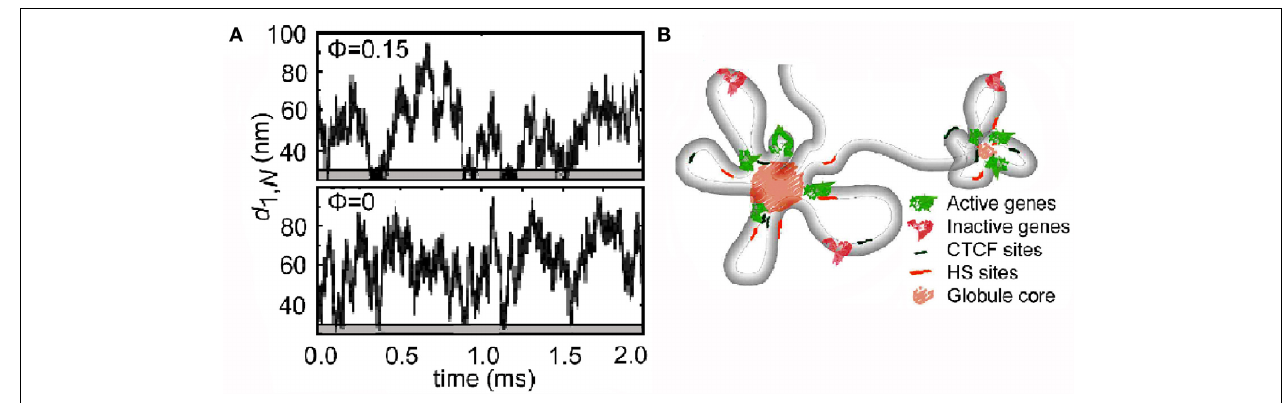
FIGURE 4 | Loops in chromatin. (A) Simulation by Langevin dynamics of the spontaneous formation of loops in a linear polymer. In the presence of crowding particles (upper panel), the minima of the end-to-end distance (d 1 , N ) which reflect looping are more frequent and persistent (lower gray areas)